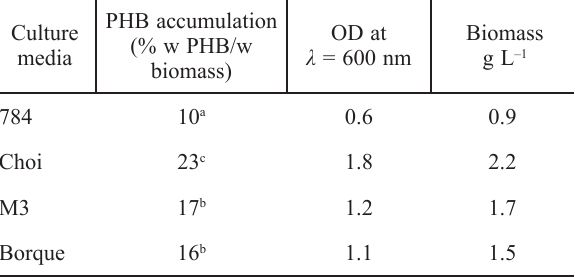
Table 3 – PHB accumulation in different culture media in a bubble column bioreactor by the isolated methanotroph Culture